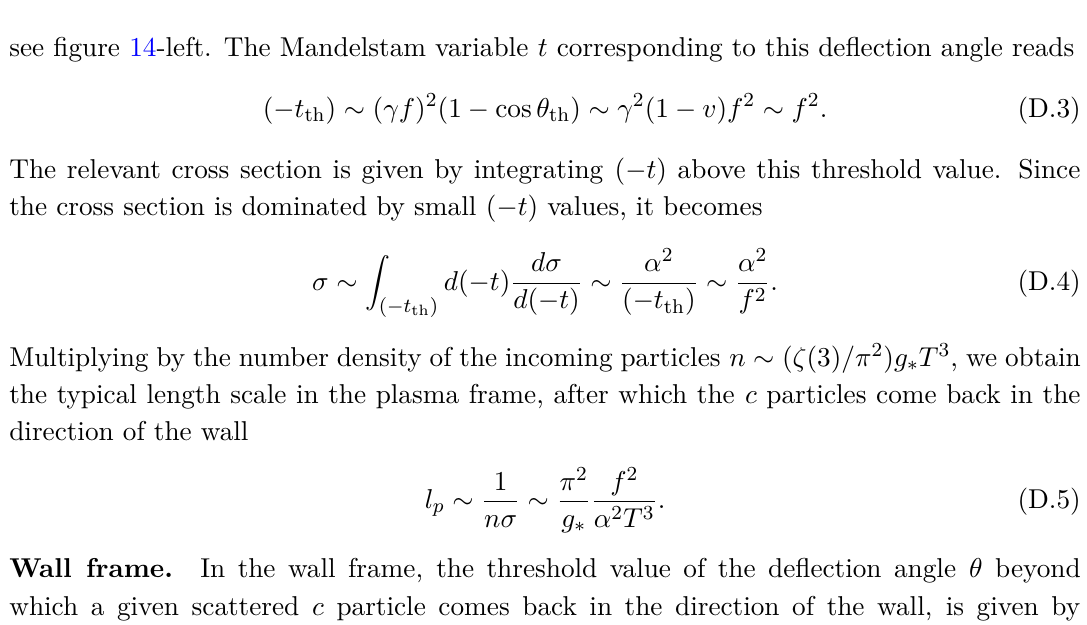
Figure 14 . (Left) Plasma frame paramaterization. (Right) Wall frame